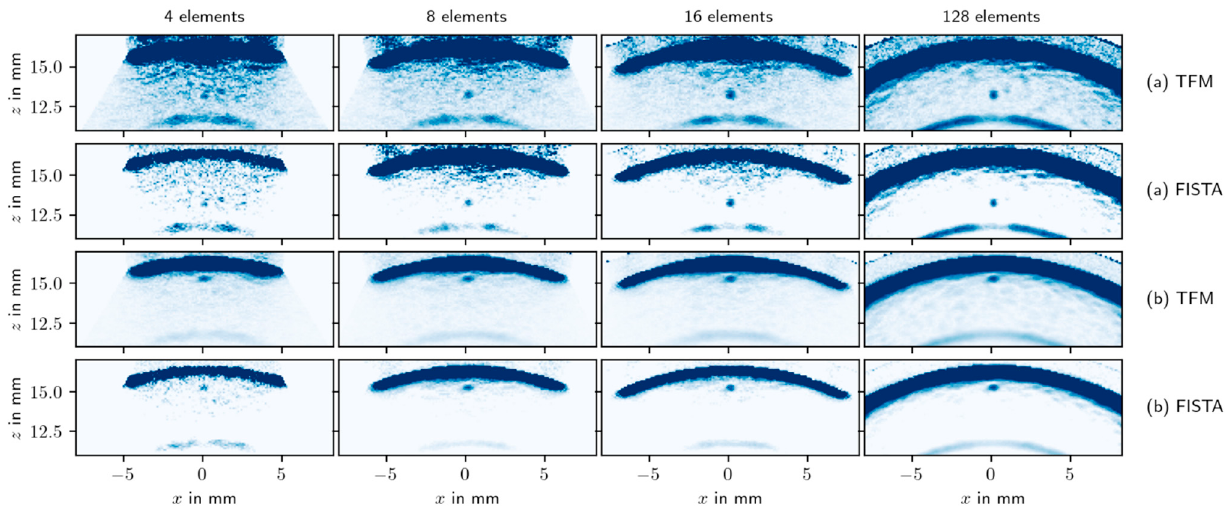
Figure 10. B-scan views of the reconstructions under presence of additive white Gaussian noise and structural noise normalized such that the maximum of the colormap of each image is the maximum value of the defect, where each column shows a different number of transmit elements. The rows indexed by ( a ), ( b ) have been calculated for a defect located at z = 13 mm and z = 15 mm, respectively.